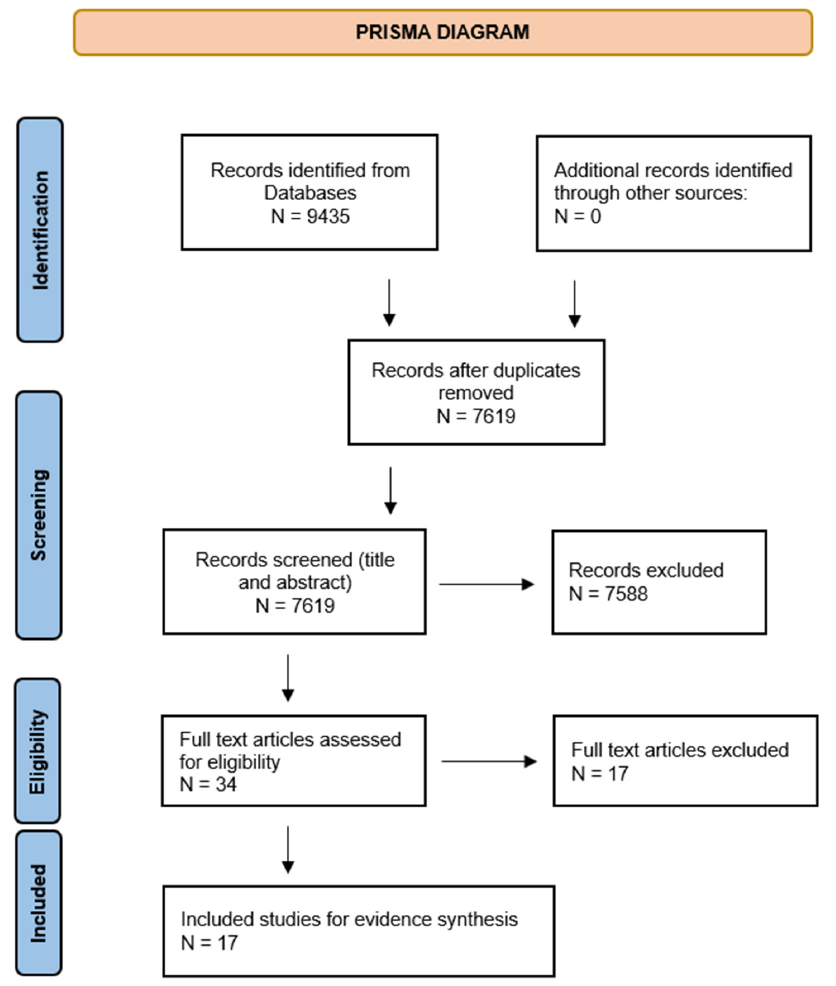
Figure 1. Prisma diagram.